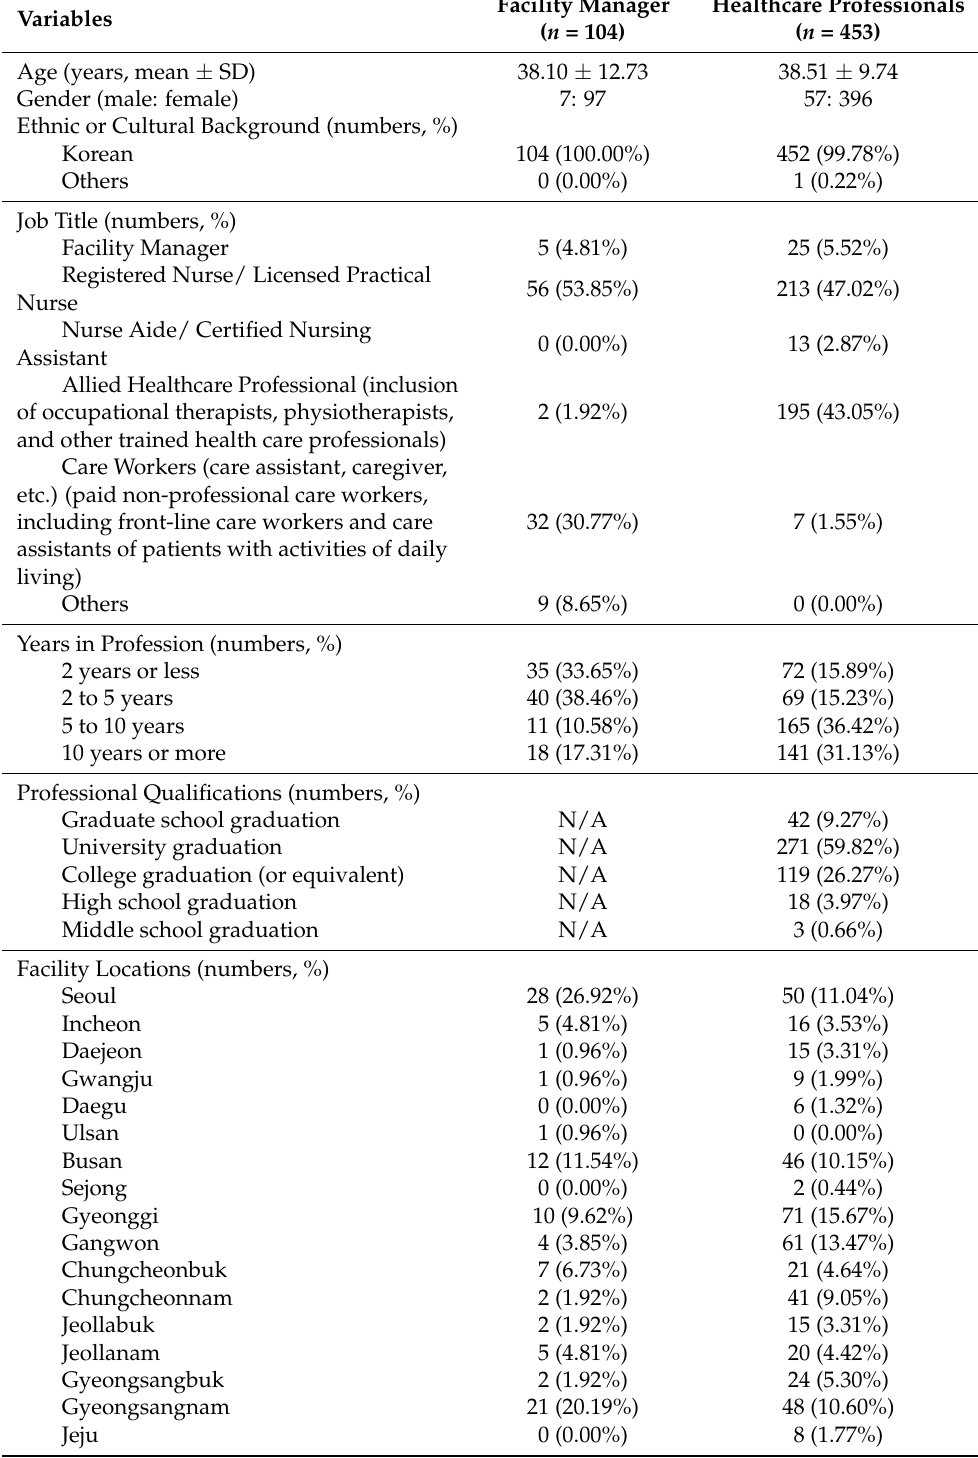
Table 1. Demographic information of enrolled participants ( n =